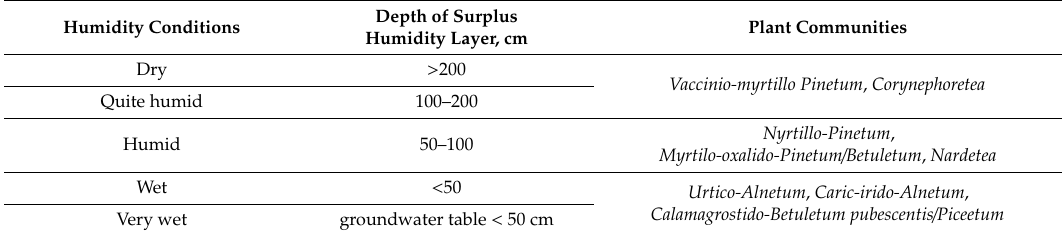
Table 1. Relations between humidity conditions and plant